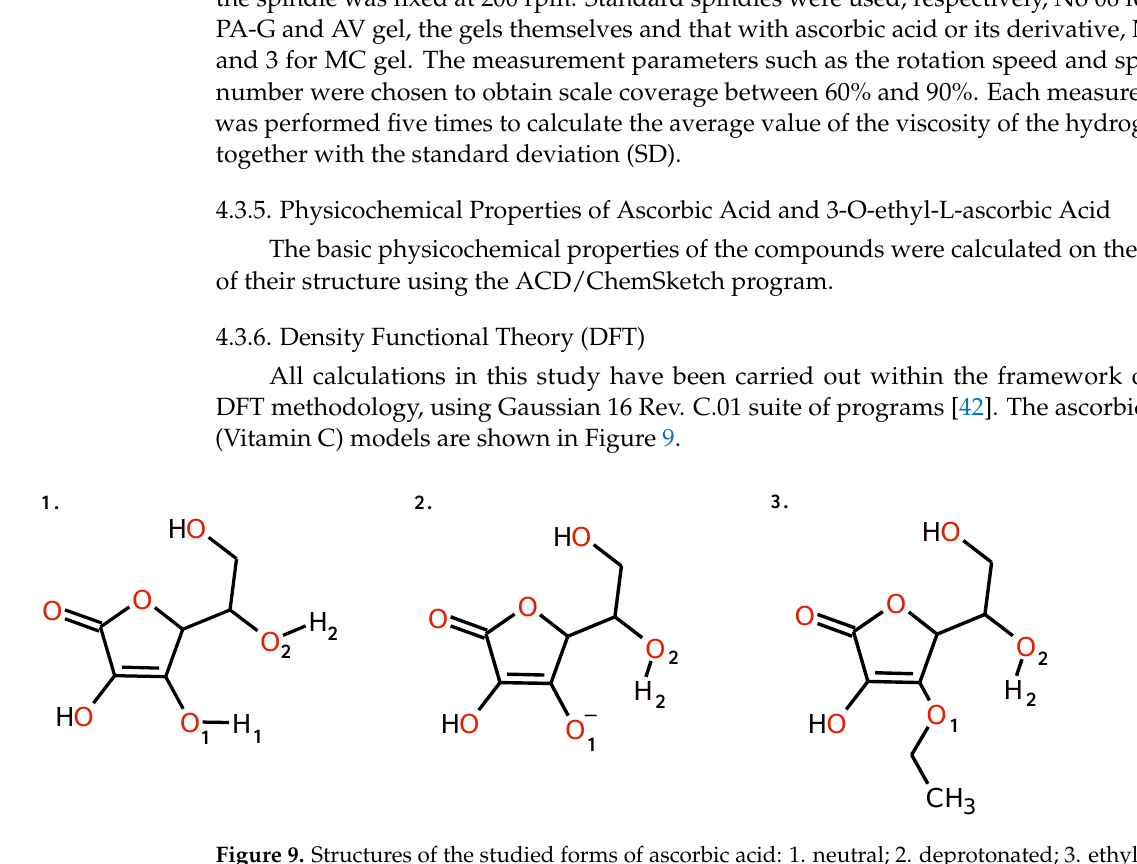
Figure 9. Structures of the studied forms of ascorbic acid: 1. neutral; 2. deprotonated; 3. ethylated.